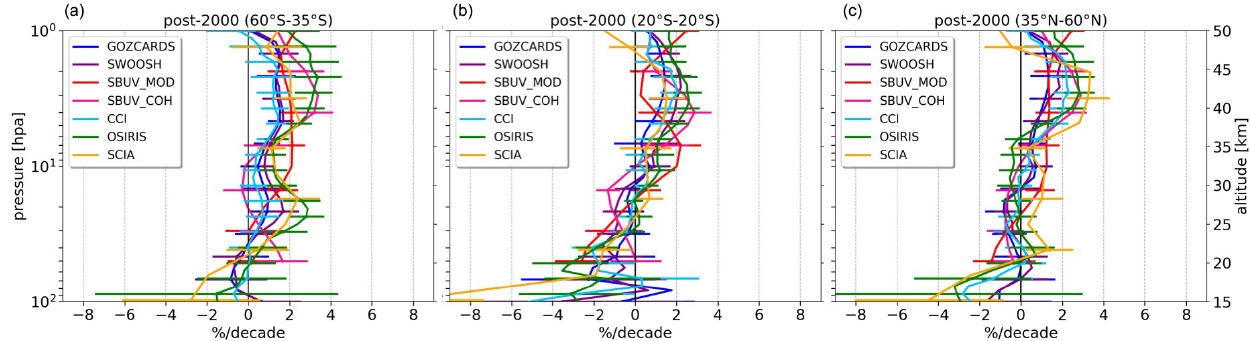
Figure 2. Merged satellite ozone trends with their 2 σ uncertainties for the post-2000 period as estimated by the LOTUS regression model for latitude bands 60–35 ◦ S (a) , 20 ◦ S–20 ◦ N (b) and 35–60 ◦ N (c) . Coloured lines are the trend estimates from the individual merged datasets on their native vertical